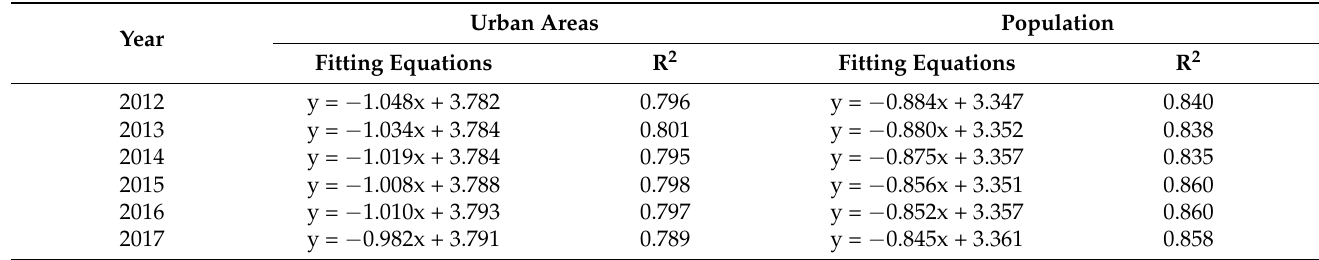
Table 3. Fitting results of rank–size in the YRD from 2012 to 2017 (y represents Zipf’s index; x in the left and right columns represent urban area and urban population, respectively).